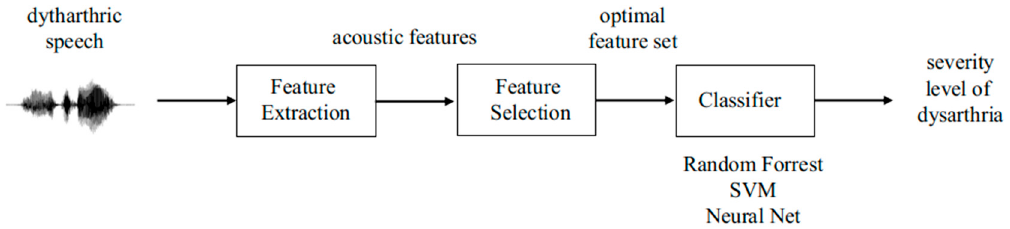
Figure 1. Block diagram of dysarthria severity assessment using acoustic features.